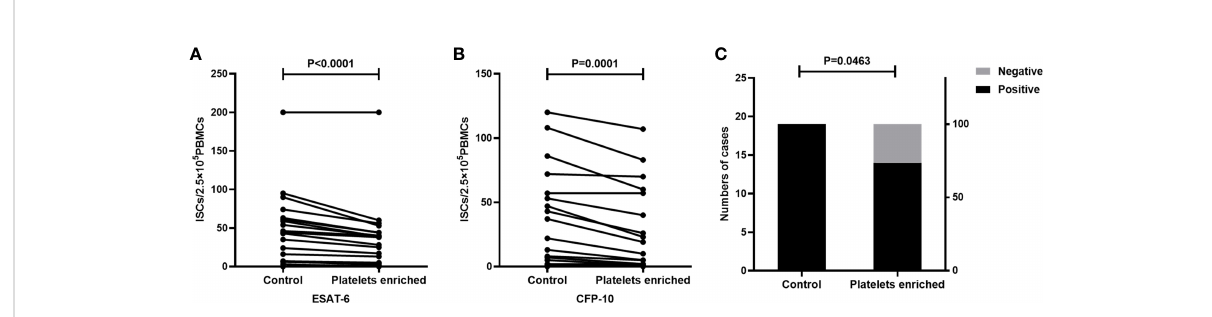
FIGURE 4 The enrichment of platelets decreased the ISCs in the T-SPOT assay. T-SPOT assays were performed with non-platelet-enriched PBMCs and platelets-enriched PBMCs with the same numbers of mononuclear cells (n=19). The ISCs in response to (A) ESAT-6 and (B) CFP-10 stimulation were counted and compared by paired Student ’ s t-test. (C) The positive rates of the T-SPOT assay were compared by the chi-square